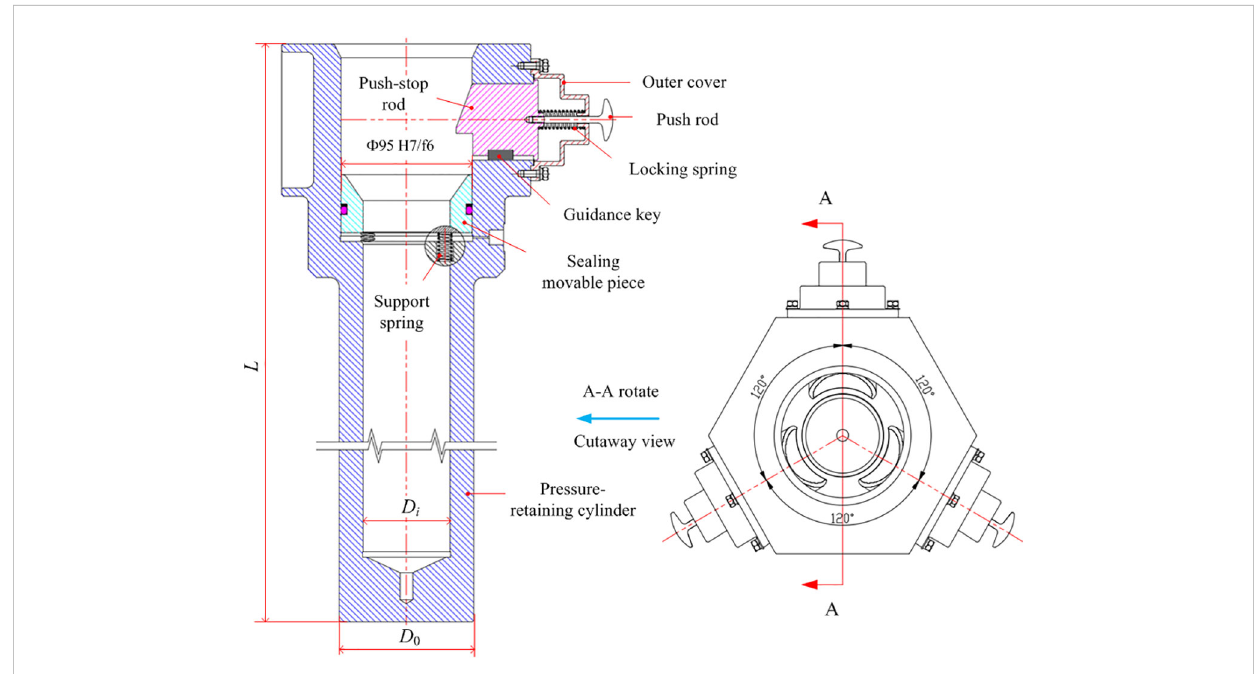
FIGURE 3 Structure scheme of the pressure-retaining unit.